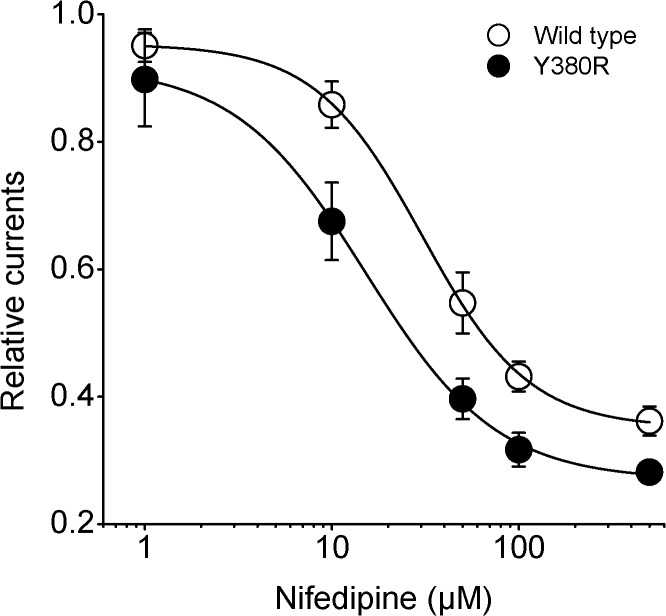
Concentration–response curves for the effects of nifedipine on wild type and Y380R mutant of Kv2.1 channels.The protocol of stimulation is identical to that in Fig 1. Whole-cell currents at +60 mV were plotted against the concentration of nifedipine. Solid lines were fit to the data of wild type Kv2.1 currents using a Hill equation with IC50 value of 37.5 μM and h value of 0.9 (n = 8). For Y380R-Kv2.1 currents, the value of IC50 is 15.2 μM and value of h is 1.1 (n = 7).